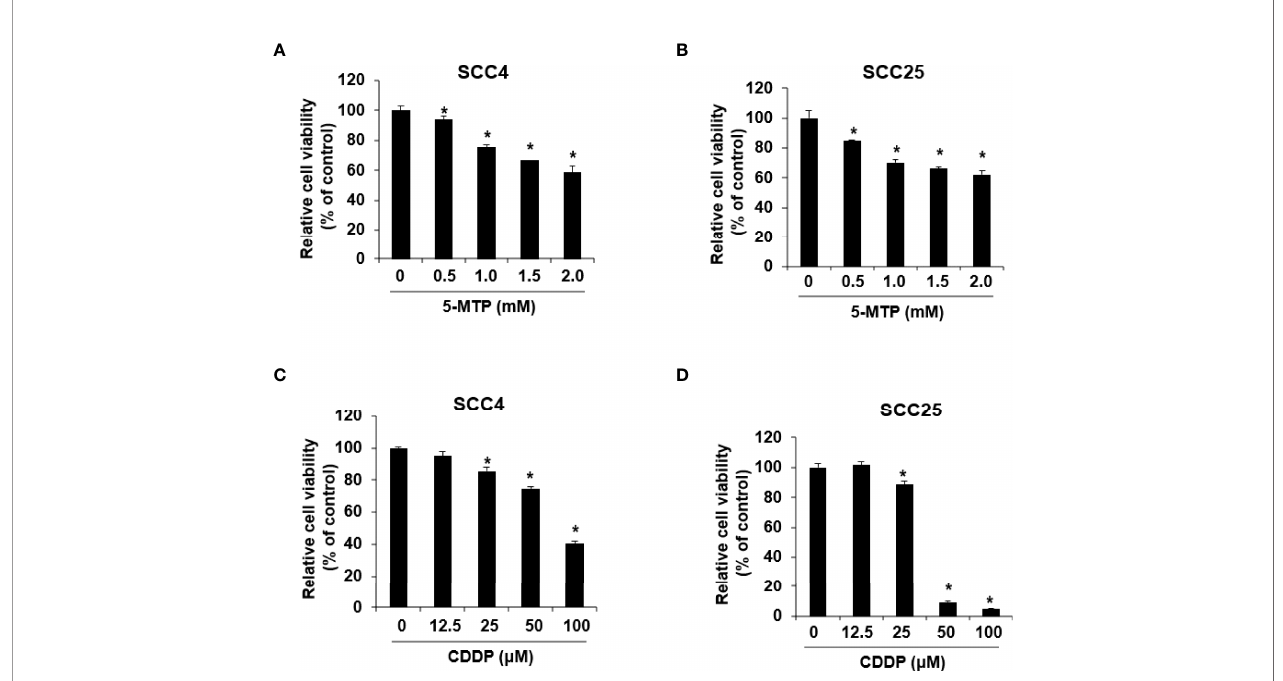
FIGURE 1 | Reduction effect of Cisplatin (CDDP) and 5-methoxytryptophan (5-MTP) on the proliferation of SSC4 and SSC25 cells. 5-MTP reduced the proliferation of SCC4 (A) and SCC25 (B) cells. CDDP reduced the proliferation of SCC4 (C) and SCC25 (D) cells. Data are presented as the mean ± SD of at least three independent experiments. Asterisks indicate signi fi cant difference in drug-treated cells at indicated concentrations singly in comparison with DMSO-treated cells. *P < 0.05.